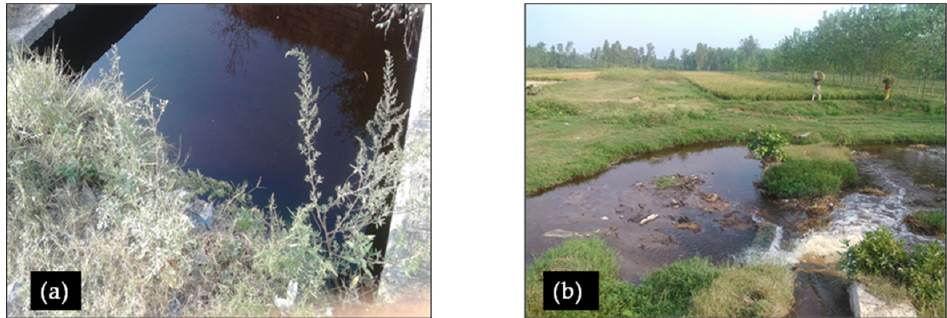
Figure 2. ( a ) Disposal channel carrying effluent of Star Paper Mill and ( b ) disposal point connecting to Kali River with a view of rice fields (Photos: Jogendra Singh).